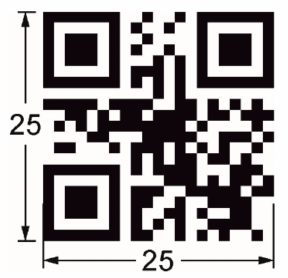
Figure 2. Technical drawing of a QR code, which was used as structural motif for the production of information carriers. All data are provided in